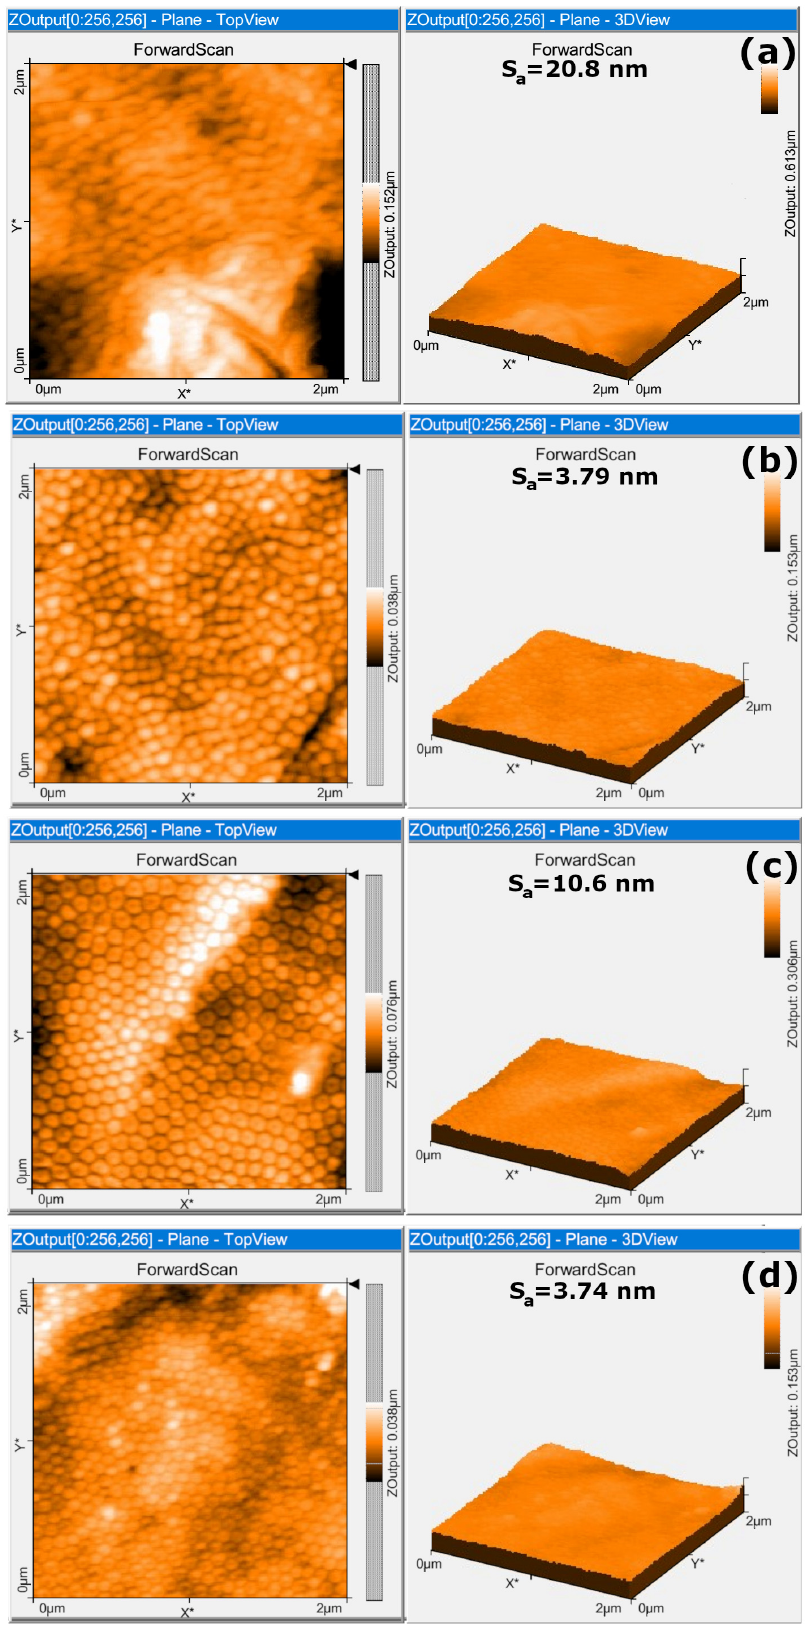
Figure 3. AFM image of the cross-section of: ( a ) TiO 2 -nt; ( b ) TiO 2 -nc; ( c ) TiO 2 -ns assembled on TiO 2 -nc; and ( d ) TiO 2 -nb assembled on TiO 2 -nc synthesized by electrochemical anodization.